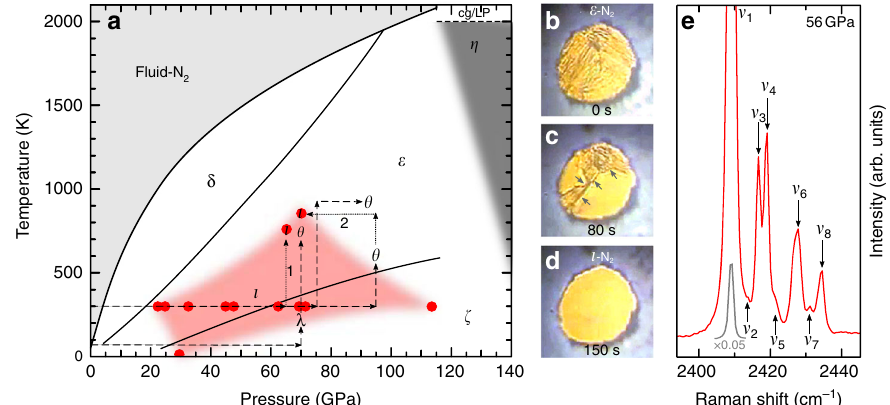
Fig. 1 The nitrogen phase and reaction diagram. a The reported P – T paths to the high-temperature molecular phases ι – N 2 and θ – N 2 are shown with dotted and dashed arrows respectively. The red shaded region approximates the known stability fi eld of ι – N 2 based on a combination of our Raman measurements and those of ref. 12 . Path 1: Isobaric heating of ε – N 2 to 750 K at 65 GPa, as performed in this study. Path 2: Isothermal decompression of θ – N 2 to 69 GPa at 850 K. P – T paths and data points are taken from refs. 11,12,21,22 which identify the phases through Raman spectroscopy. Black phase-boundaries are based on refs. 21 – 23 . Phases α , β , γ , δ * , ζ ' , κ and λ – N 2 are omitted for clarity. b – d Micrographs of the visual changes across the ε – N 2 → ι – N 2 phase transition. The sample is approximately 60 μ m in diameter and 15 μ m thick. The time from the onset of the phase-transition is shown on each frame. The arrows in c indicate the progression of the ε – N 2 → ι – N 2 phase boundary. e Vibrational Raman spectrum of ι – N 2 once recovered to ambient temperature. The inset spectrum (light grey) shows ν 1 scaled by a factor of 0.05 to display it